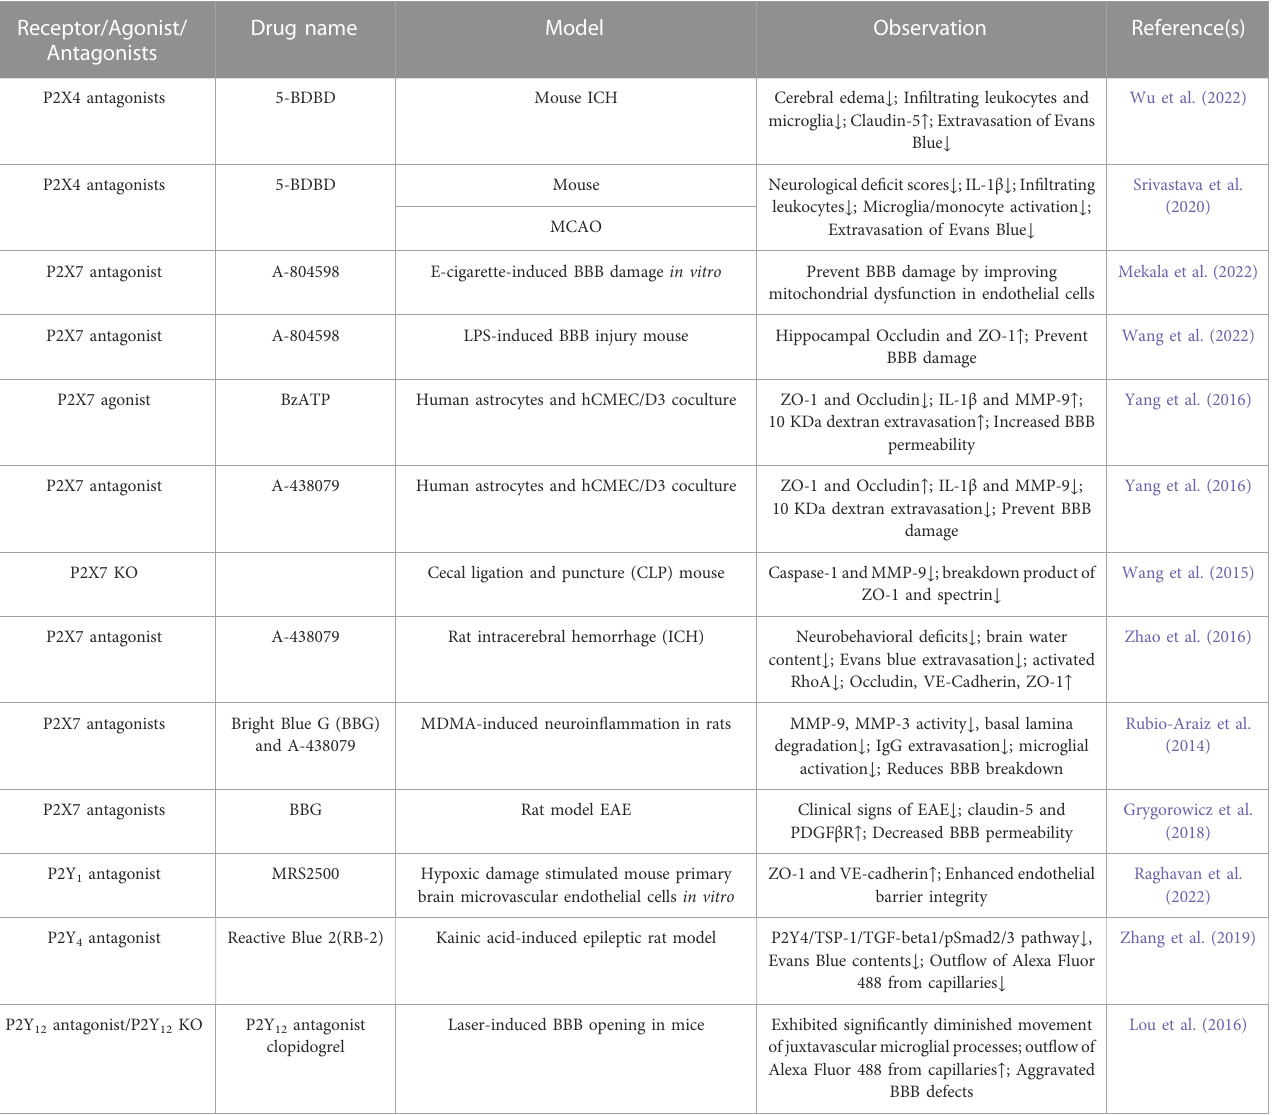
TABLE 1 Effect of P2 receptors agonist/antagonist on blood-brain barrier